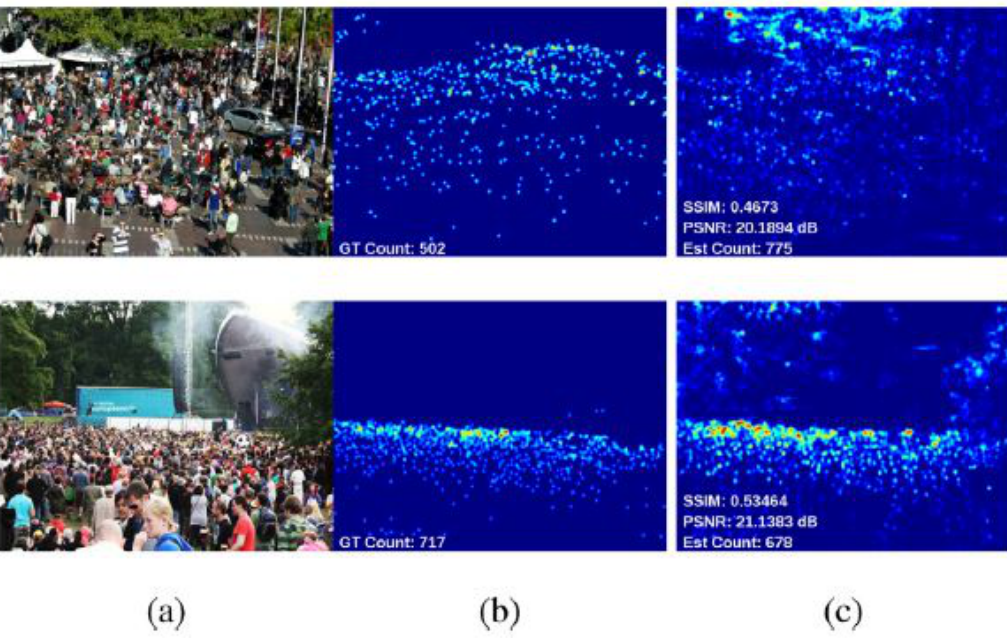
Figure 2. ( a ) Input image, ( b ) Ground truth, and ( c ) Estimated density maps. Image from